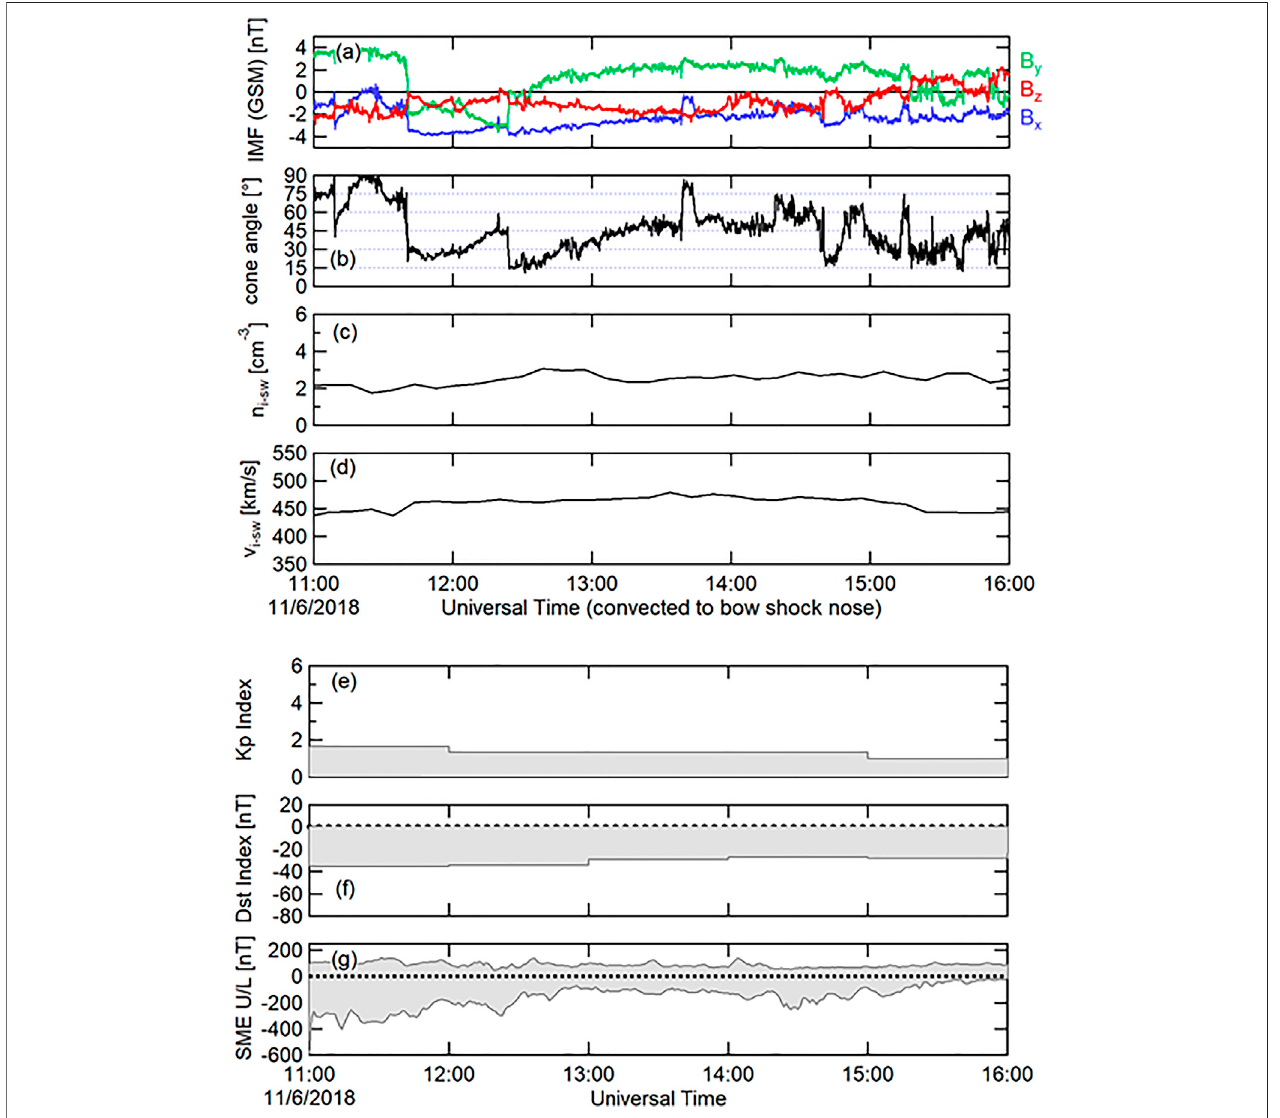
FIGURE 1 | Observations of the solar wind by the ARTEMIS 1 spacecraft, convected in time by 11.2 min to the bow shock nose. (A) IMF components in GSM coordinates; (B) IMF cone angle; (C) Solar wind ion density; (D) Solar wind bulk speed; (E) Kp index; (F) Dst index; (G) SME U/L index (similar to the AE index).